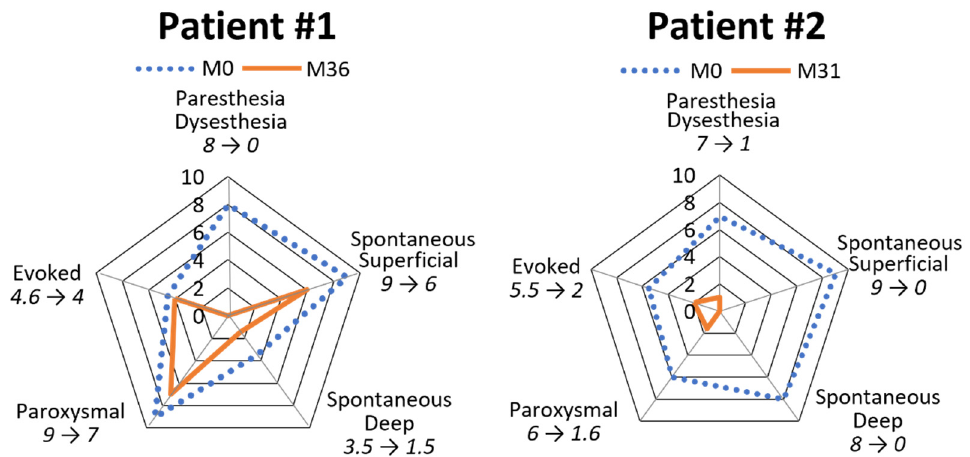
Figure 2. Graphical representation of Neuropathic Pain Symptom Inventory. The evolution of the five factors is shown from the beginning of treatment to present for the two patients, and the variation in score is indicated below each factor (M = month).